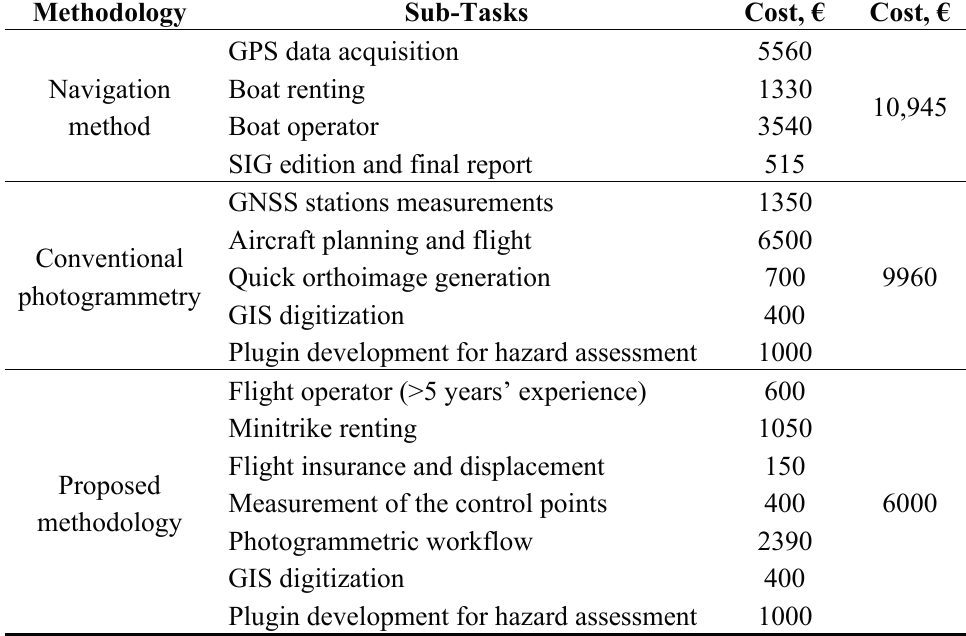
Table 3. Total cost of the different evaluated methodologies to detect LWD in the 132-km stretch of the Júcar